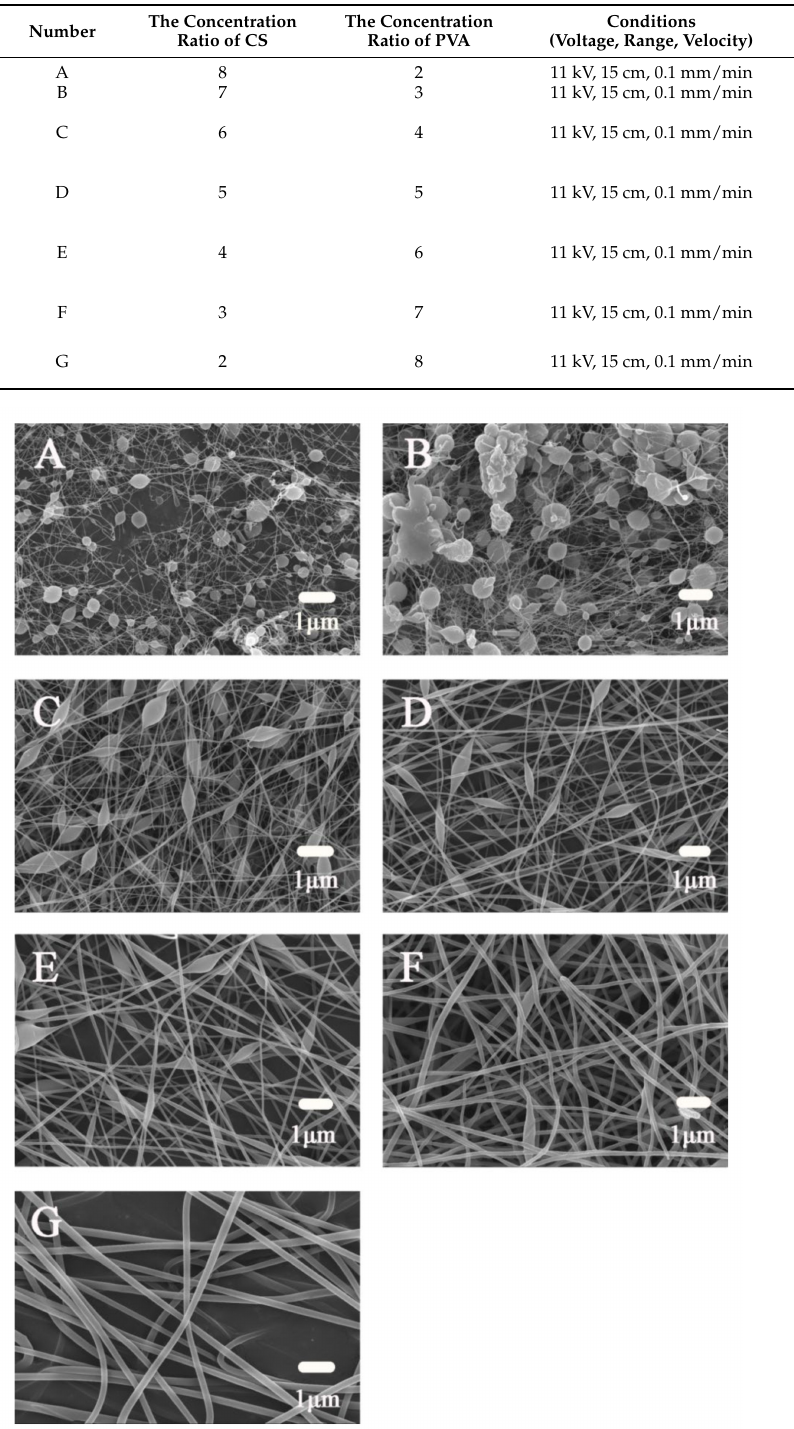
Figure 3. Effects of CS and PVA blend ratio on fiber morphology (( A ) CS:PVA = 8:2; ( B ) CS:PVA = 7:3; ( C ) CS:PVA = 6:4; ( D ) CS:PVA = 5:5; ( E ) CS:PVA = 4:6; ( F ) CS:PVA = 3:7; ( G ) CS:PVA =